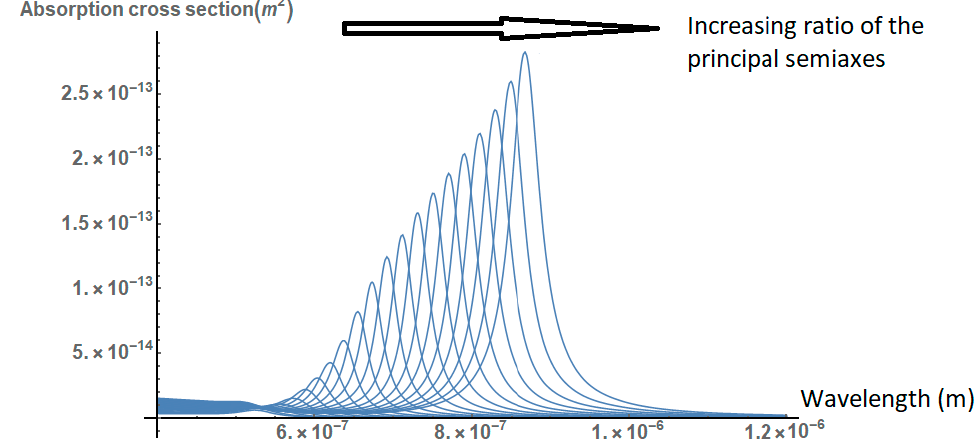
Figure 5. Absorption cross section of a gold nanoparticle in the form of a prolonged ellipsoid, for different values of the ratio of the principal semi axes ( 1 ≤ r ≤ 5 ) . The cross section is increased and red-shifted as the ratio of the principal axes increases.